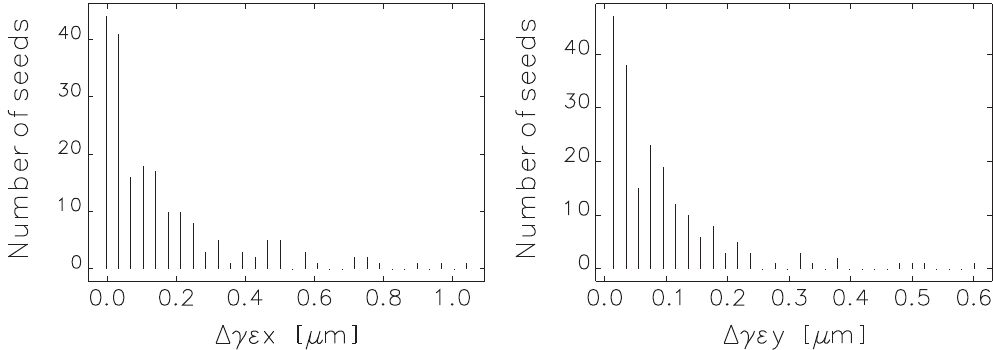
FIG. 11. Left: horizontal projected normalized emittance growth at bunch compressor one end. Right: vertical projected normalized emittance growth at bunch compressor one end. In the simulation 50 μ m is assumed for the offset between beam position monitor (BPM) electrical center and quadrupole magnetic center. One-to-one steering method (from one quad center to the next) is adopted here.